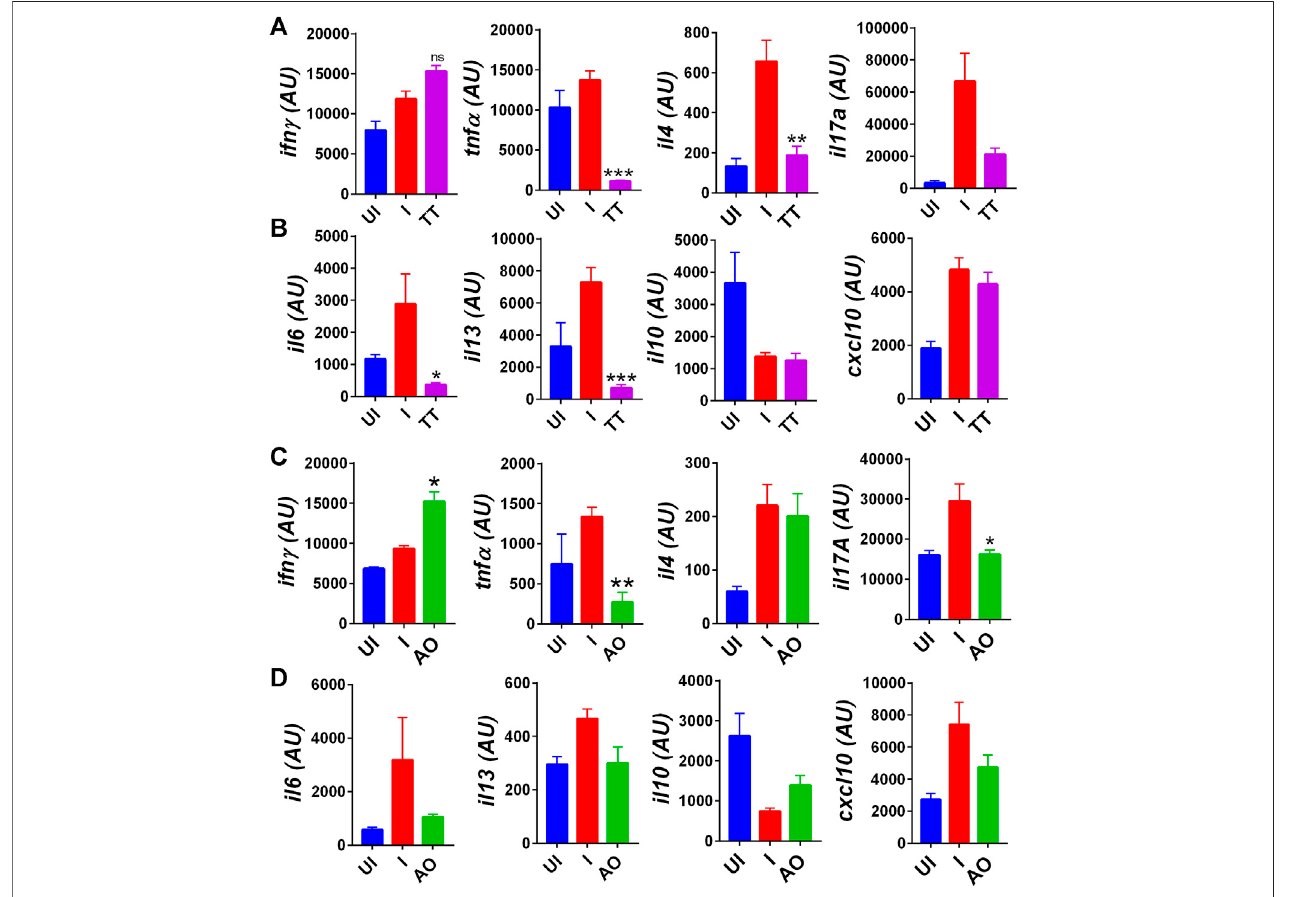
FIGURE4| Immuno-modulatoryeffectofTTandAOoncytokineexpressioninsplenocytes.RelativemRNAexpressionpro fi lingwascarriedoutinUI,I,TT,andAO splenocytes samples for (A) T helper cell cytokines for TT samples. (B) pro-in fl ammatory and anti-in fl ammatory cytokines for TT samples. (C) T helper cell cytokines for AO samples. (D) pro-in fl ammatory and anti-in fl ammatory cytokines for AO samples. Bar graph showing mean ± SEM. ns (cid:2) non-signi fi cant ** p < 0.05 ** p < 0.01, *** p < 0.001, **** p < 0.0001 (one-way